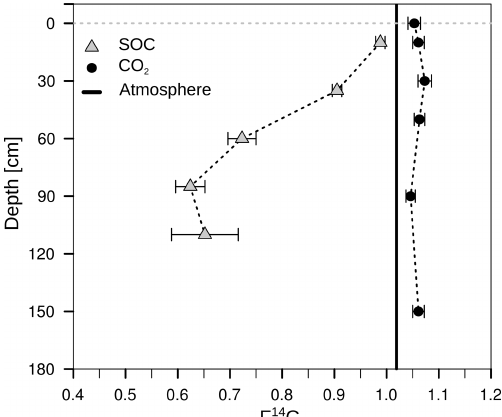
Figure 11. Mean 14 C concentration ( F 14 C) of bulk soil (grey tri- angles; data from Angst et al., 2016) and CO 2 in the soil atmo- sphere (black dots). The solid black lines represent the annual av- erage F 14 C values in the atmosphere from 2014, measured at the Jungfraujoch alpine research station, Switzerland (Ingeborg Levin and Samuel Hammer, personal communication, 2015).